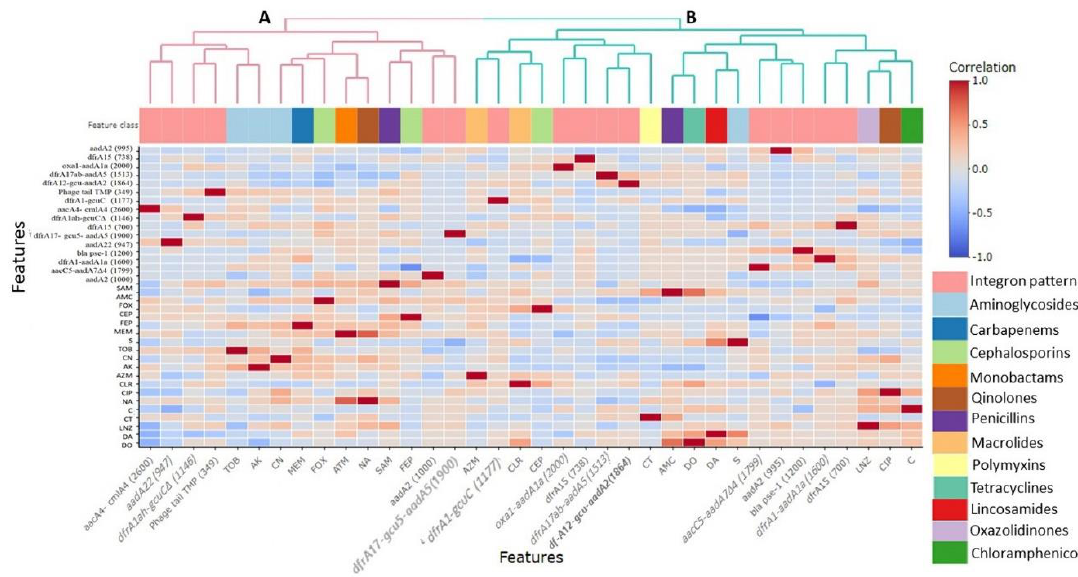
Figure 2. Pairwise correlation ( R ) among different antimicrobial resistance phenotypes and integron gene cassette arrays. Red and blue colors indicate positive and negative correlations, respectively. The color key refers to the correlation coefficient ( R ). The darker colors imply stronger positive or negative correlations. The hierarchical clustering of the variables is shown as a dendrogram illustrating different clusters with different colors and letters (e.g., A and B). Variables that are identical among all strains are excluded, and thus not shown in this figure. Classes of antimicrobials are color-coded below the dendrogram.